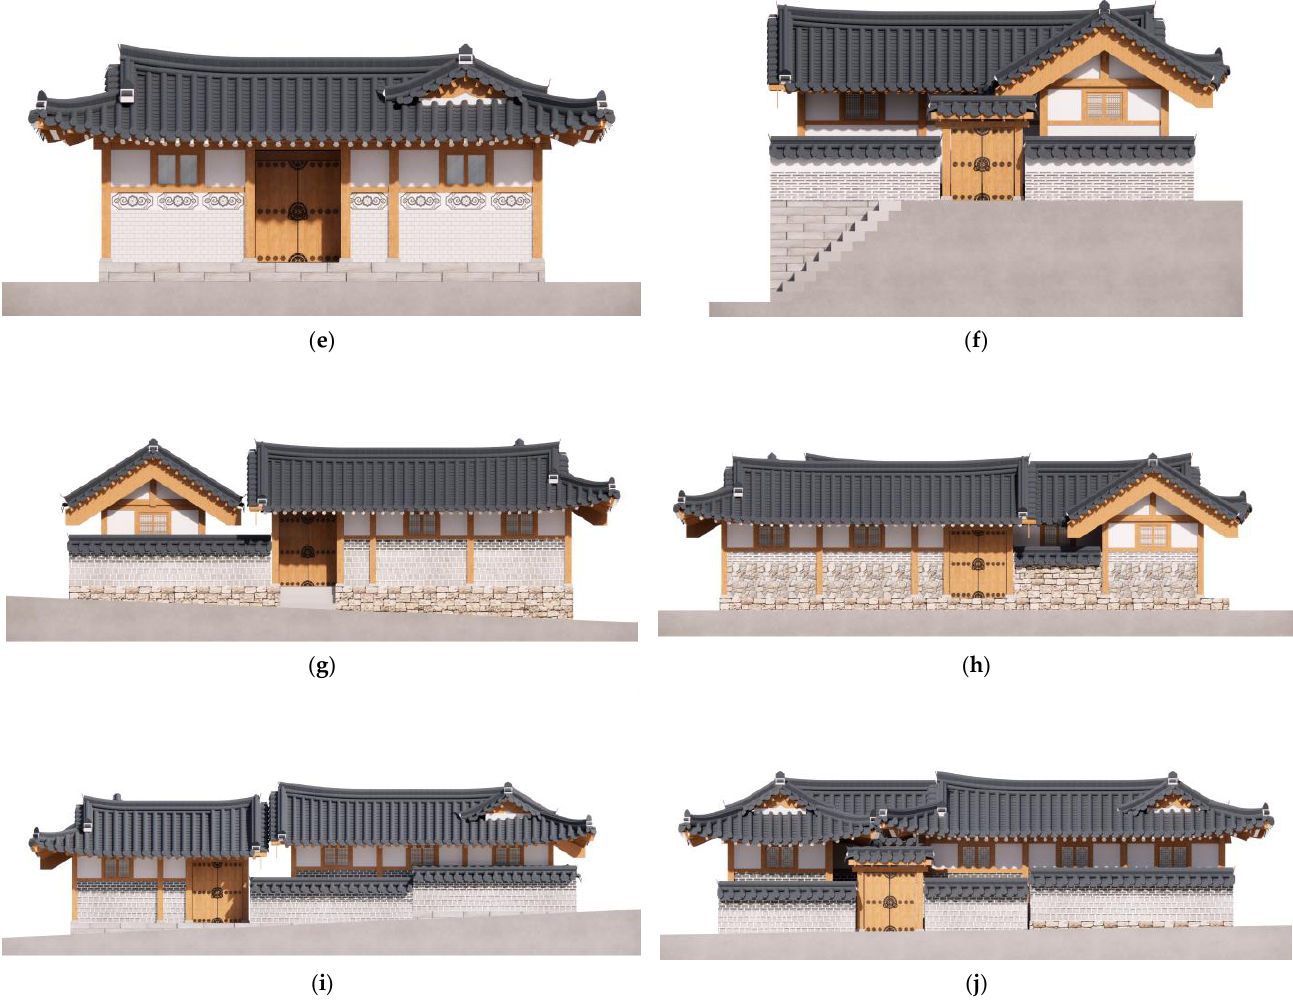
Figure 10. Facade image of Hanok by the combination of form elements. Reprinted/adapted with permission from Ref. [3]. 2018, Donghwa Shon: The facade of a Hanok is composed of a combination of various elements. These figures are exemplary images showing the facade of each Hanok by the combination of elements simplified with the alphabets in Table 1. ( a ) a2 + b2 + c5 + w3 + x2 + y1 + l1